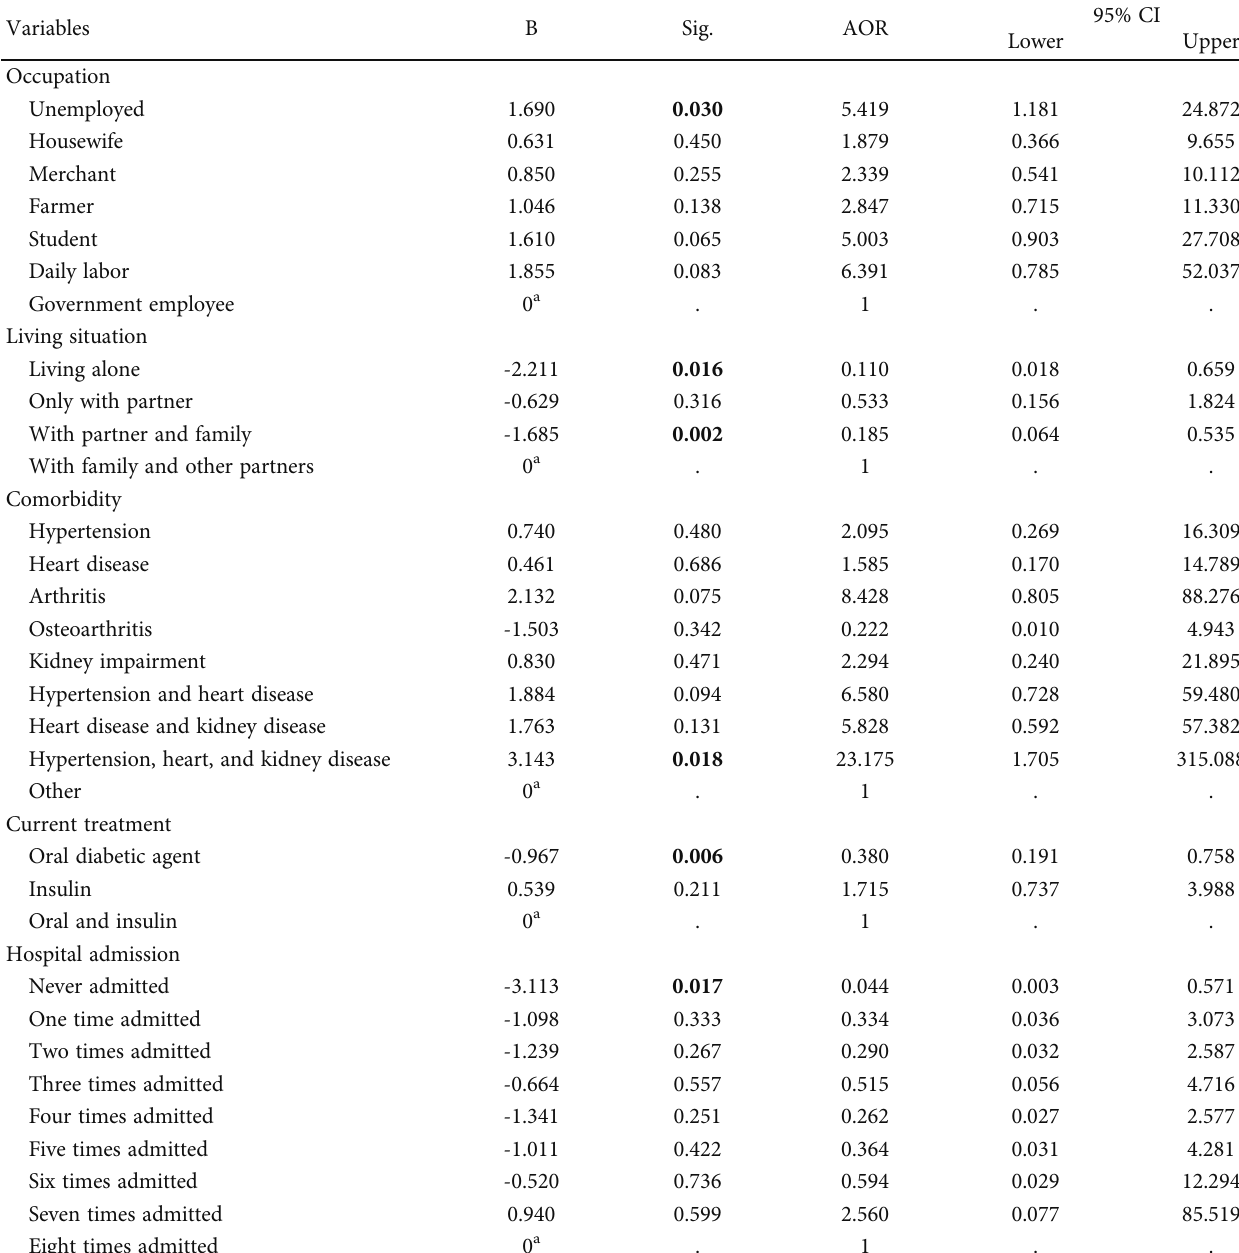
Table 4: Ordinal logistic regression of persons with diabetes ’ perceptions of family burden and associated factors at a university hospital. Variables B Sig. AOR